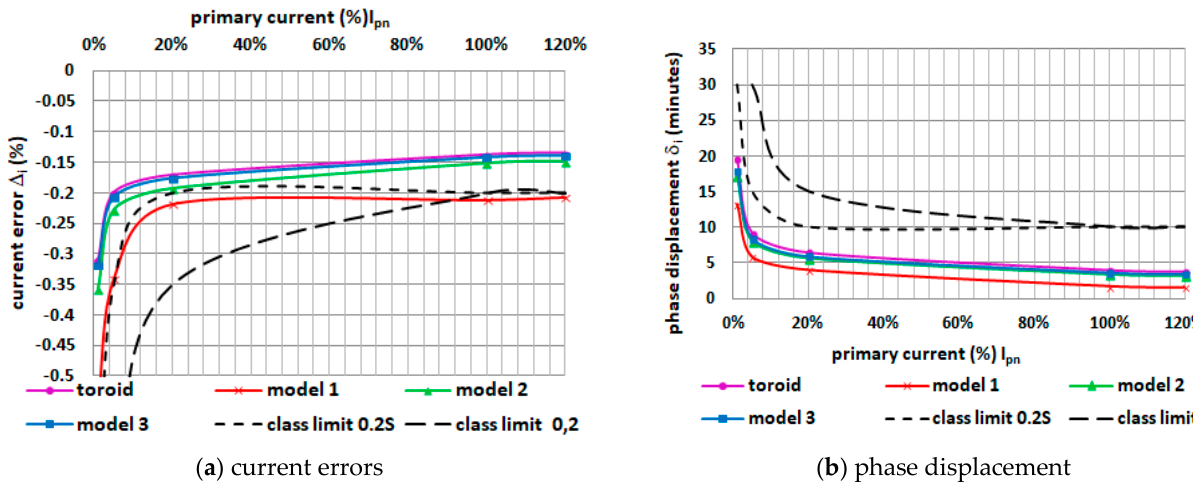
Figure 10. Comparison of the characteristics of the current error ( a ) and phase displacement ( b ) for 600 A/5 A of current transformers with different cores and secondary windings arrangements at a power load of S n = 5 VA. cos φ = 0.8 (I pn = 600 A).